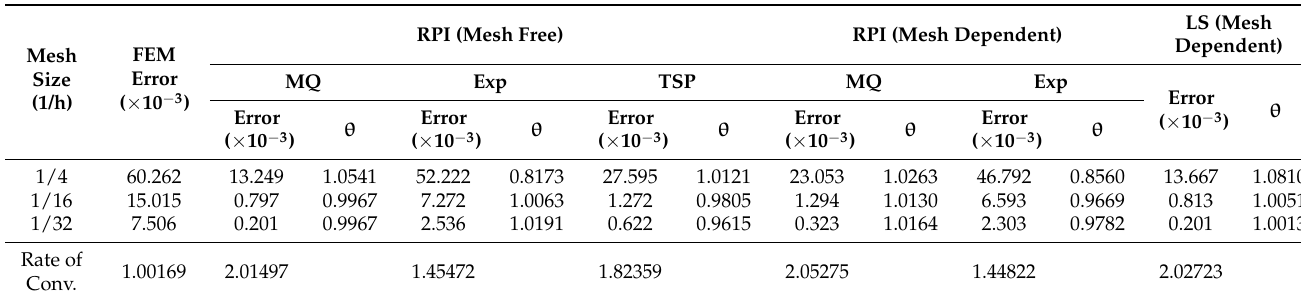
Table 6. Error convergence and global effectivity ( θ ) obtained for RPI with radial basis function types and least square based displacement recovery techniques (quadrilateral, energy norm).